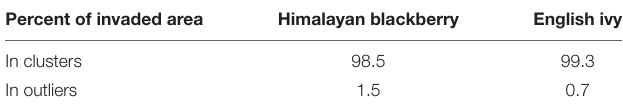
TABLE 5 | Percent of area invaded by Himalayan blackberry ( Rubus armeniacus ) and English ivy ( Hedera helix ) in significant clusters and outliers as determined by Anselin’s Local Moran’s I in Surrey, BC,